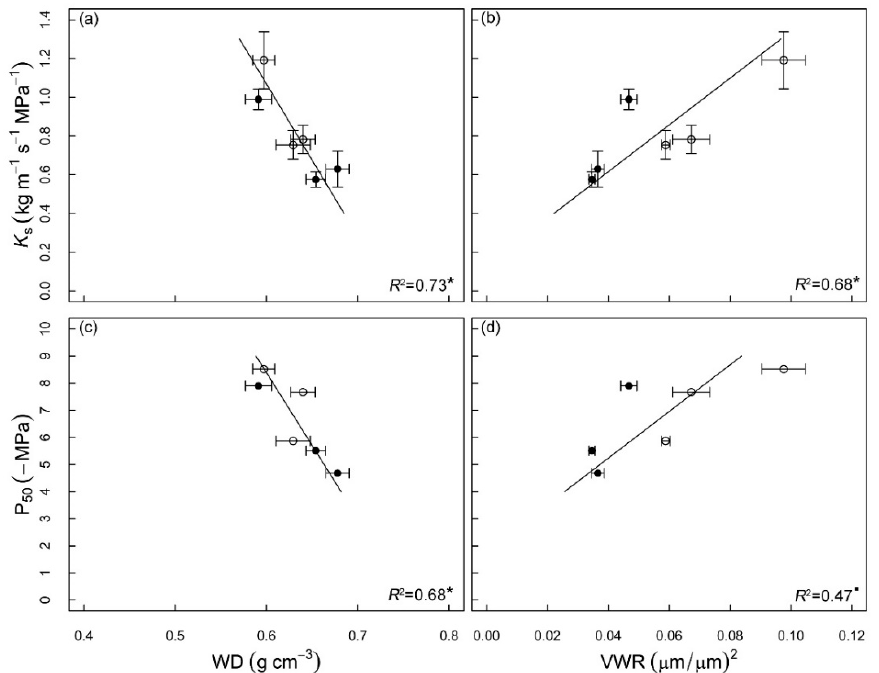
Figure 4. The relationship between wood density (WD) and sapwood-specific hydraulic conductivity ( K S ; a ), water potential at 50% loss of conductivity (P 50 ; c ), as well as the relationship between vessel wall reinforcement (VWR) and sapwood-specific hydraulic conductivity ( K S ; b ), water po- tential at 50% loss of conductivity (P 50 ; d ) across the two mangrove species in the three sites. Open circles represent Avicennia marina and filled circles represent Aegiceras corniculatum . Error bars indicate standard error of mean. Adjusted R 2 of significant Pearson’s correlation is shown. Asterisk indicates significance level (* p < 0.05; ● —marginally significant).